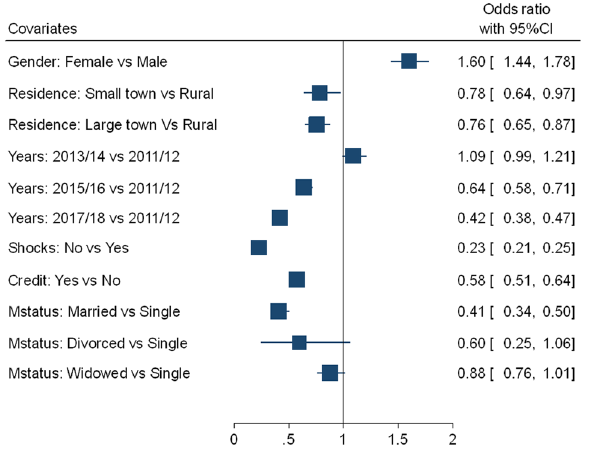
Figure 4. Estimated parameters (with 95% CI) of geo-additive model for linear effects on the household level food insecurity.